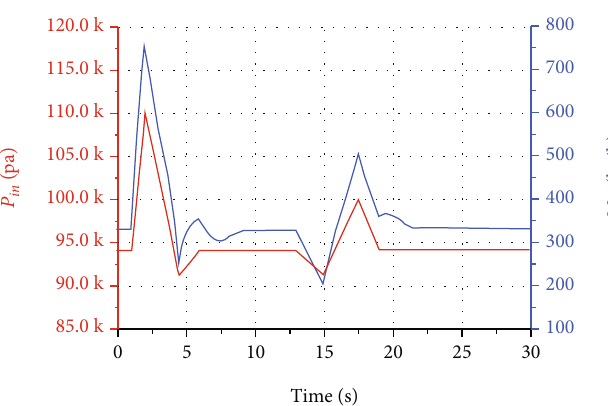
Figure 21: Cabin in fl ow fl uctuation: inlet pressure and mass fl ow.